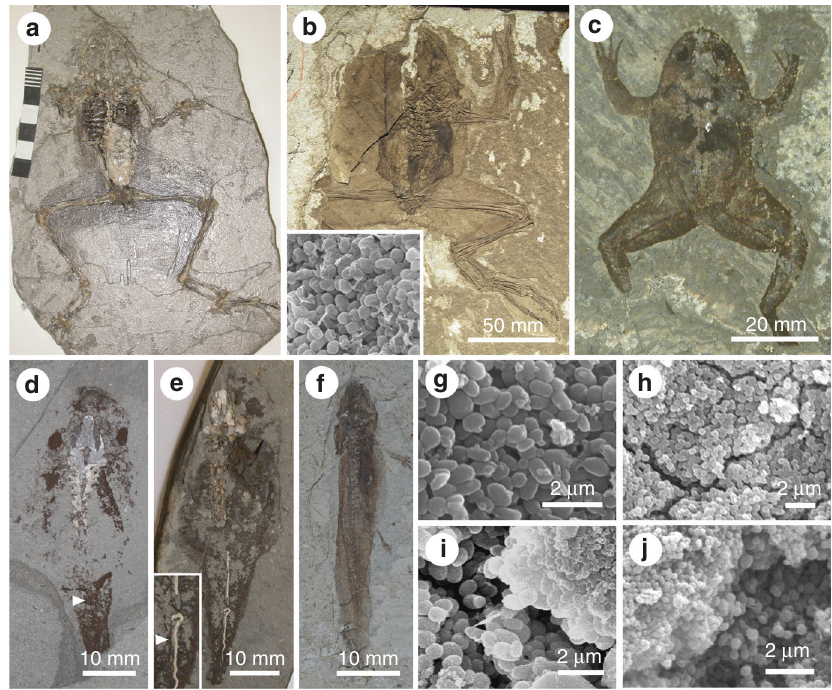
Fig. 3 Fossil amphibian soft tissues. a – c Frogs from Libros (Miocene, Spain) ( a MNCN 63776, Museu Nacional de Ciencias Naturales, Madrid), Bechlejovice (Oligocene, Czech Republic) ( b NMP 39449, National Museum Prague), and Messel (Eocene, Germany) ( c SMF-ME-00978, Forschungsinstitut und Naturmuseum Senckenberg, Frankfurt). Torsos show dark patches of non-integumentary melanosomes. Inset in b shows melanosomes from the torso. d , e Tadpoles from Libros. Lungs are dark patches in the torso ( d MNCN 63848); the notochord, two closely spaced parallel lines ( d , e NHM 49999, Natural History Museum, London, UK). f Salamander from Daohuguo (Middle Jurassic; CNU-V-1264, Capital Normal University, Beijing, China). Torso shows conspicuous dark patches. g – j Scanning electron micrographs of melanosomes in frogs ( g – i ) and tadpoles ( j ) from Libros. g Non-integumentary melanosomes. h Integumentary melanosomes. i , j Size-speci fi c layers of melanosomes. i Integumentary melanosomes (top right) overlying non-integumentary melanosomes (lower left). j Size-speci fi c layers of non-integumentary melanosomes, re fl ecting vertical superposition of different internal tissues in vivo. Scale bars, 60 mm ( a ), 50 mm ( b ), 20 mm ( c ), 10 mm ( d , f ), 2 µ m ( g – j